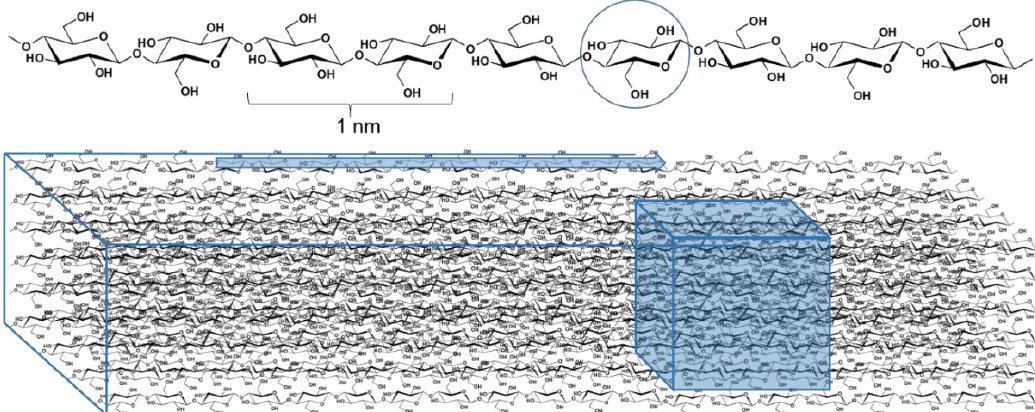
Figure 1. Simplified sketch of the hierarchical levels or dimensions of substituent distributions in cellulose derivatives: in the glucosyl unit (first dimension, 1D), along a cellulose chain (heterogeneity of second order, second dimension, 2D), and over the bulk material (heterogeneity of third order, third dimension, 3D).